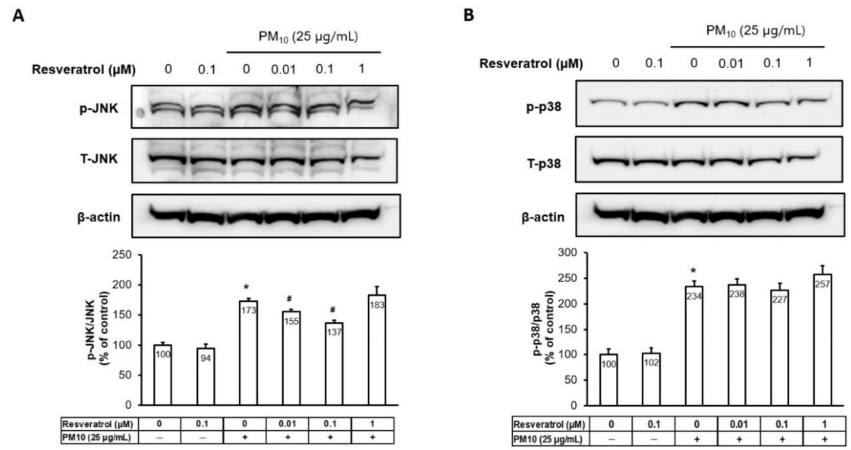
Figure 5. E ff ects of resveratrol on transcription factor activator protein-1 components and p38 MAPK phosphorylation in human keratinocytes following PM treatment. ( A ) Protein levels of JNK and ( B ) p38 MAPK were analyzed by Western blotting and densitometry. Equal amounts of protein loading were confirmed using JNK, p38, and actin antibodies. * p < 0.05 and # p < 0.05 compared with untreated cells and PM-treated cells, respectively. PM, particulate matter; JNK, Jun N-terminal kinase; MAPK, mitogen-activated protein kinase; p, phosphorylated; T, total. 2.6. Resveratrol Inhibits PM-Induced AhR Activation in Keratinocytes Intranuclear expression of AhR was increased after keratinocytes were exposed to PM, and pretreatment with resveratrol reduced this expression in a dose-dependent manner until the 0.1 µ M concentration (Figure 6).